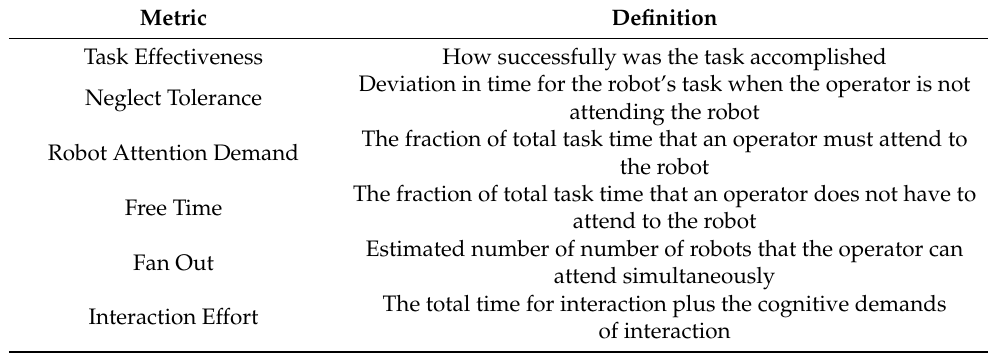
Table 2. Metrics for user awareness in HMI.